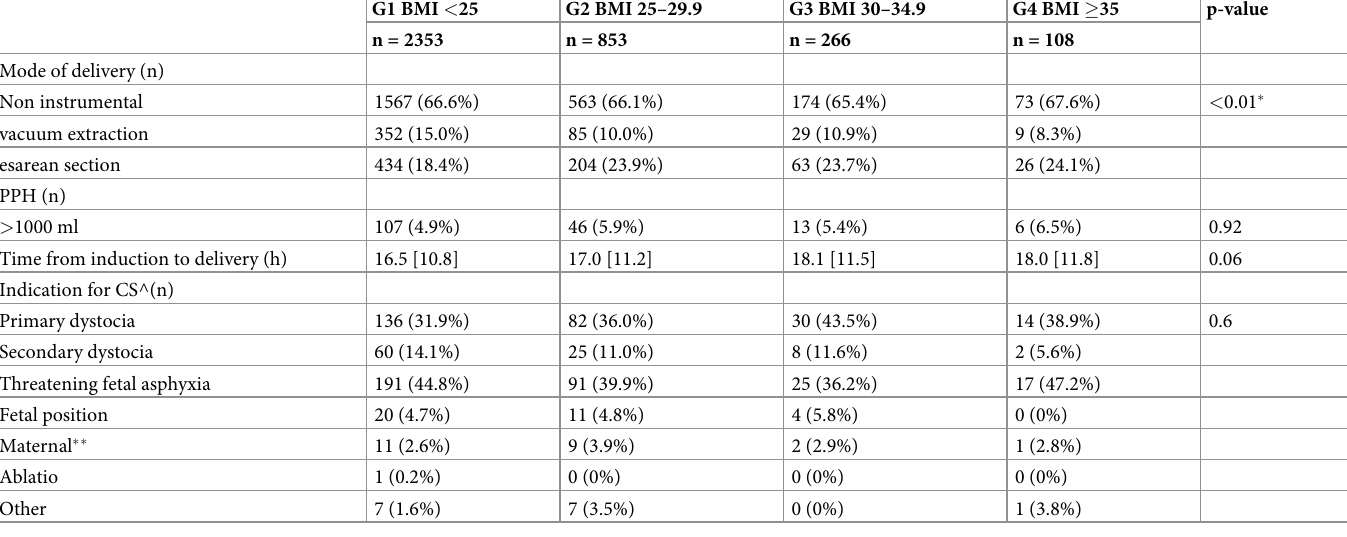
Table 2. Birth outcome presented by BMI group (G1-G4). Data are presented as numbers (%) or mean (standard deviation [SD]). P-values < 0.05 were considered sta- tistically significant � .